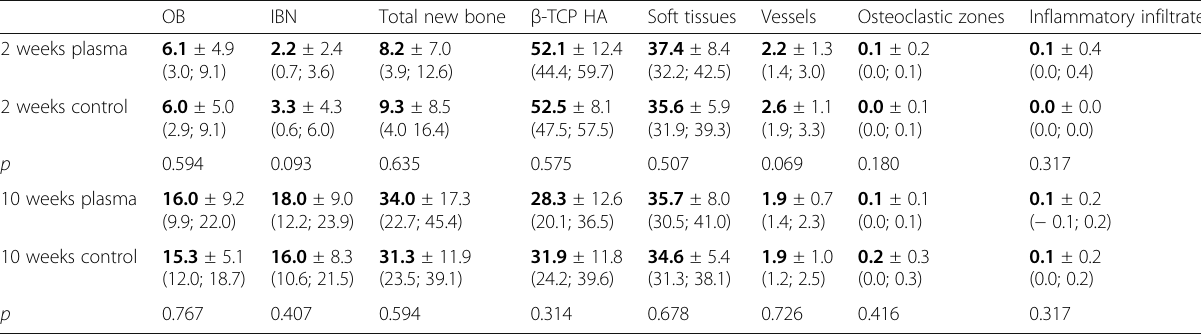
Table 1 Tissues components in percentages (%) in the elevated area in the plasma and control sites after 2 and 10 weeks of healing. Mean values (in bold) ±standard deviation and 95% confidence interval (upper; lower)